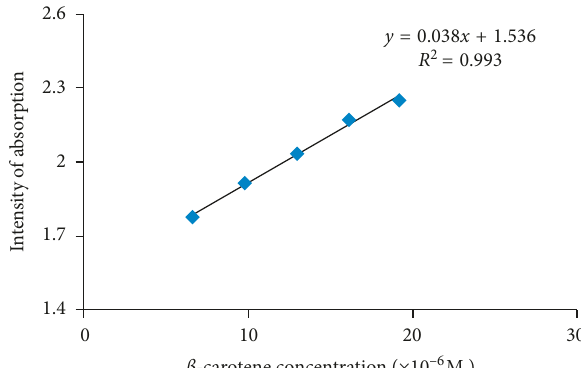
Figure 7: Dependence between the Soret band intensity of the MnTTPCl solution and β -carotene concentration.